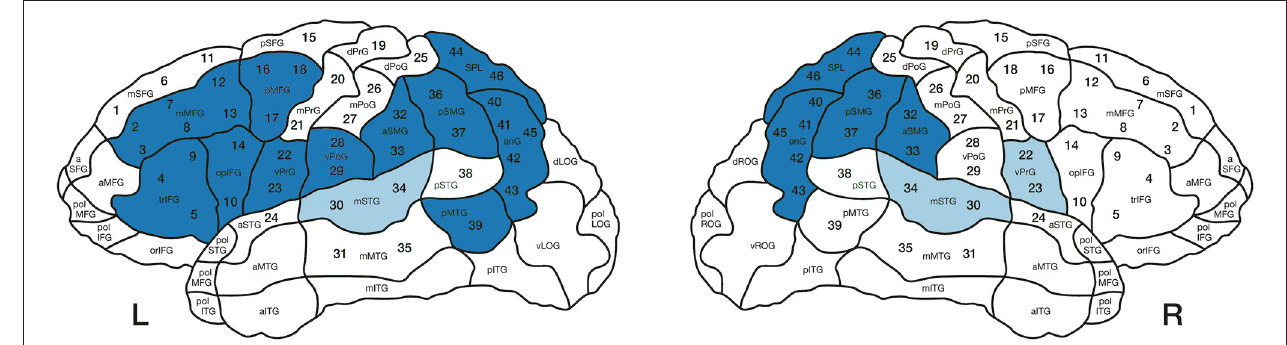
FIGURE 1 | Summary of areas that have been reported to elicit more activation during the processing of transitive over intransitive verbs (blue areas) and those for the opposite contrast (i.e., more activation for intransitive compared to transitive verbs; light blue areas). Numbers indicate the 46 stimulation points used for the current study according to CPS regions (Corina et al., 2010). L, Left hemisphere; R, Right hemisphere.